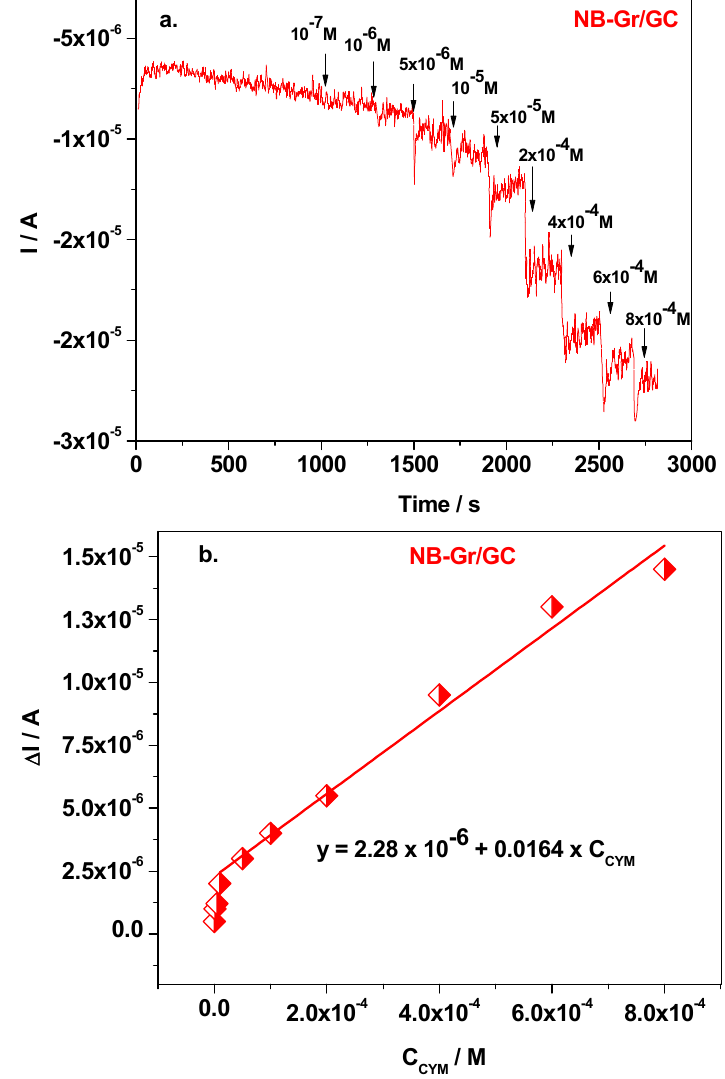
Figure 8. Amperometric curve recorded with NB-Gr/GC electrode in pH 6 BR supporting electrolyte, after the addition of known concentrations of CYM; applied potential − 0.8 V vs. Ag/AgCl ( a ); the corresponding calibration plot within the linear range: 5 × 10 − 6 –8 × 10 − 4 M ( b ).